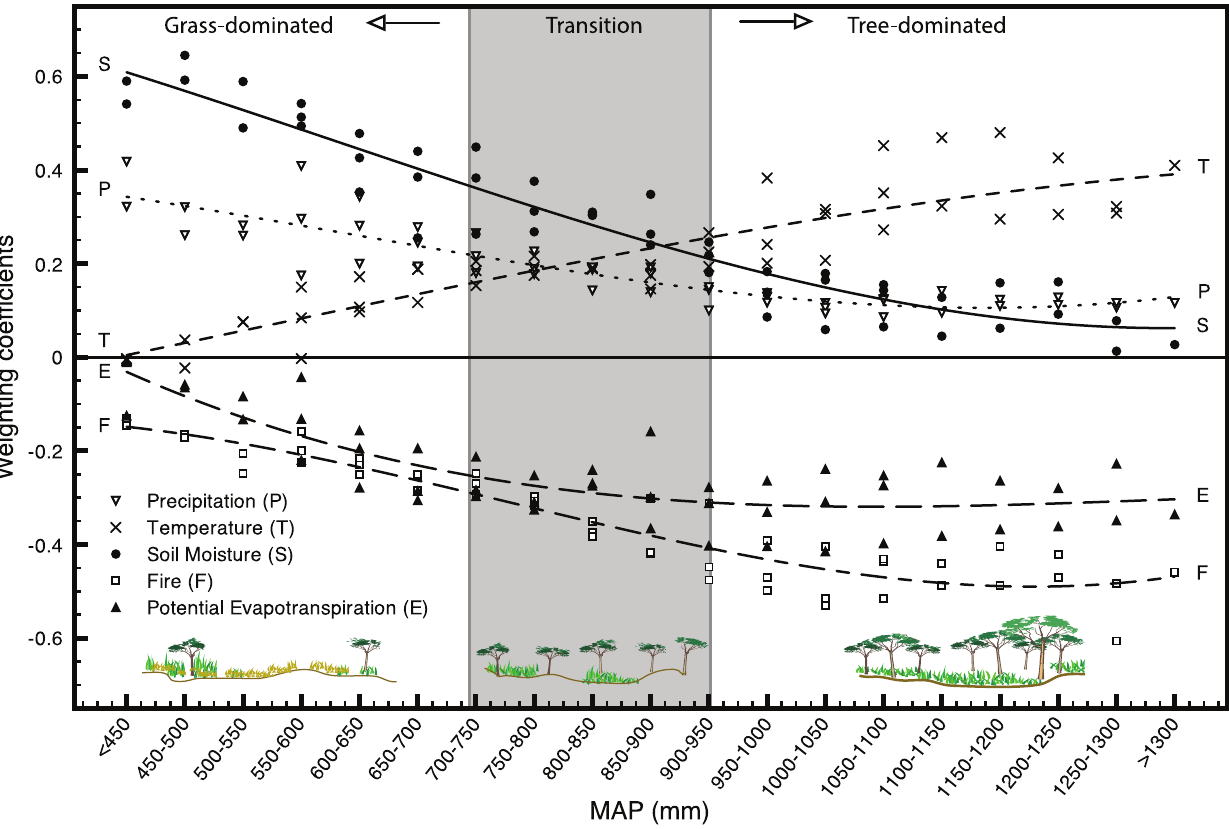
Figure 8. Environmental drivers of savanna ecosystems as a function of mean annual precipitation (MAP). Weight (or importance) of each driver of NDVI is described by Model III b k,n regression coefficients along MAP gradients. Lines represent the main trajectories and highlight the shift in the importance of environmental drivers along a gradient from grass- to tree-dominated savanna landscapes.